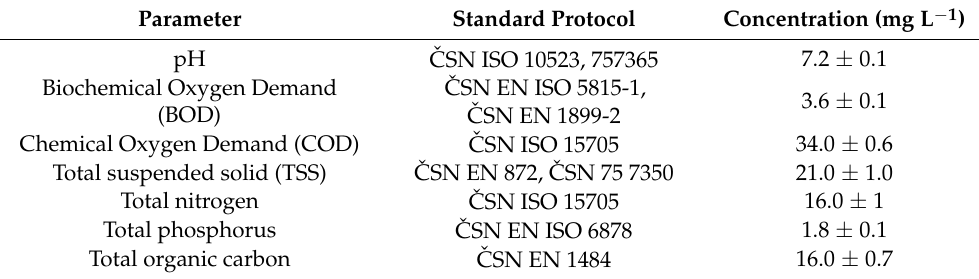
Table 1. General parameters of wastewater examined: pH, Biochemical Oxygen Demand (BOD), Chemical Oxygen Demand (COD), Total Suspended Solid (TSS), Total Nitrogen, Total Phosphorus, Total Organic Carbon (TOC). Values represent means ± standard deviations ( n = 3).